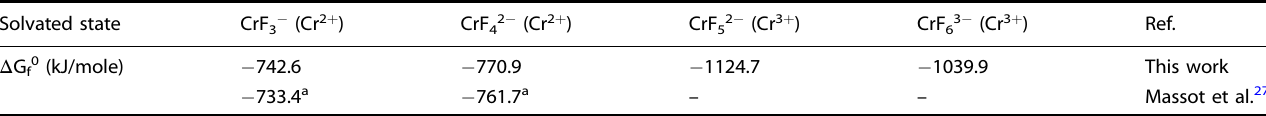
Table 2. Calculated standard Gibbs free energy of formation ( Δ G 0 600